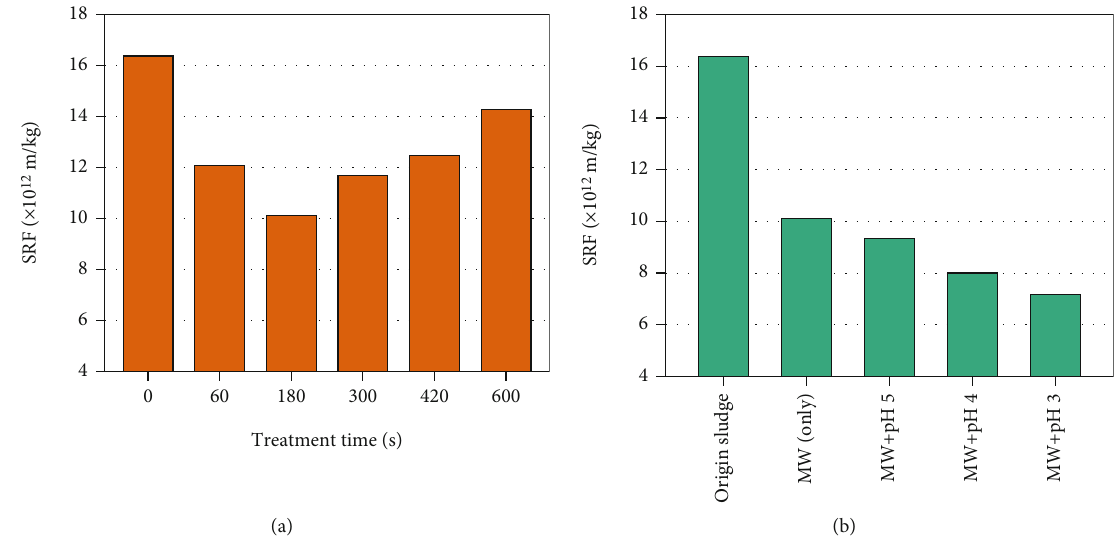
Figure 3: SRF measurement results: (a) SRF of sludge treated by 700W microwave for di ff erent times; (b) SRF of sludge with di ff erent pHs treated by microwave (MW) at 700 W for 180s.